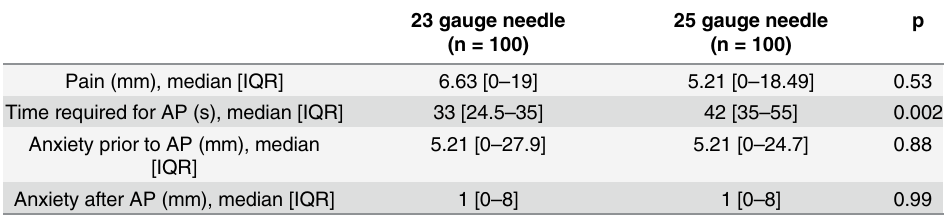
Table 2. Time required for and pain and anxiety related to arterial